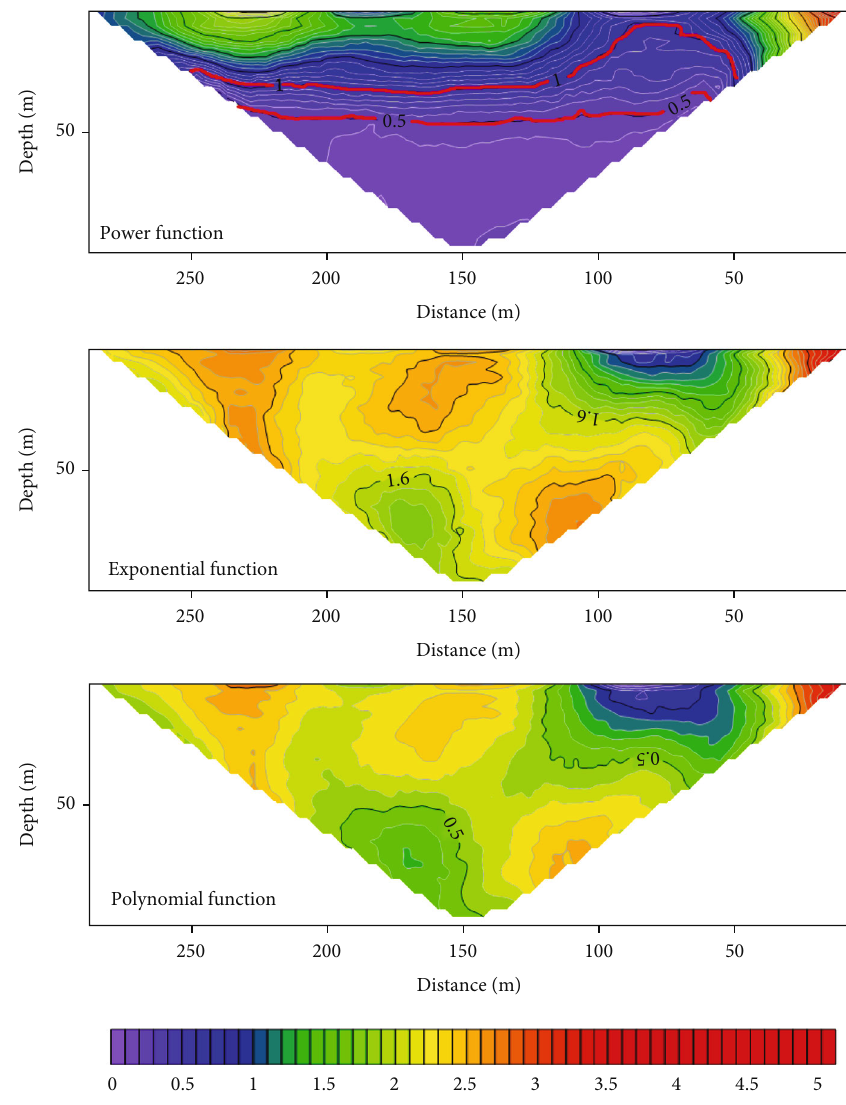
Figure 9: The fi t of each function